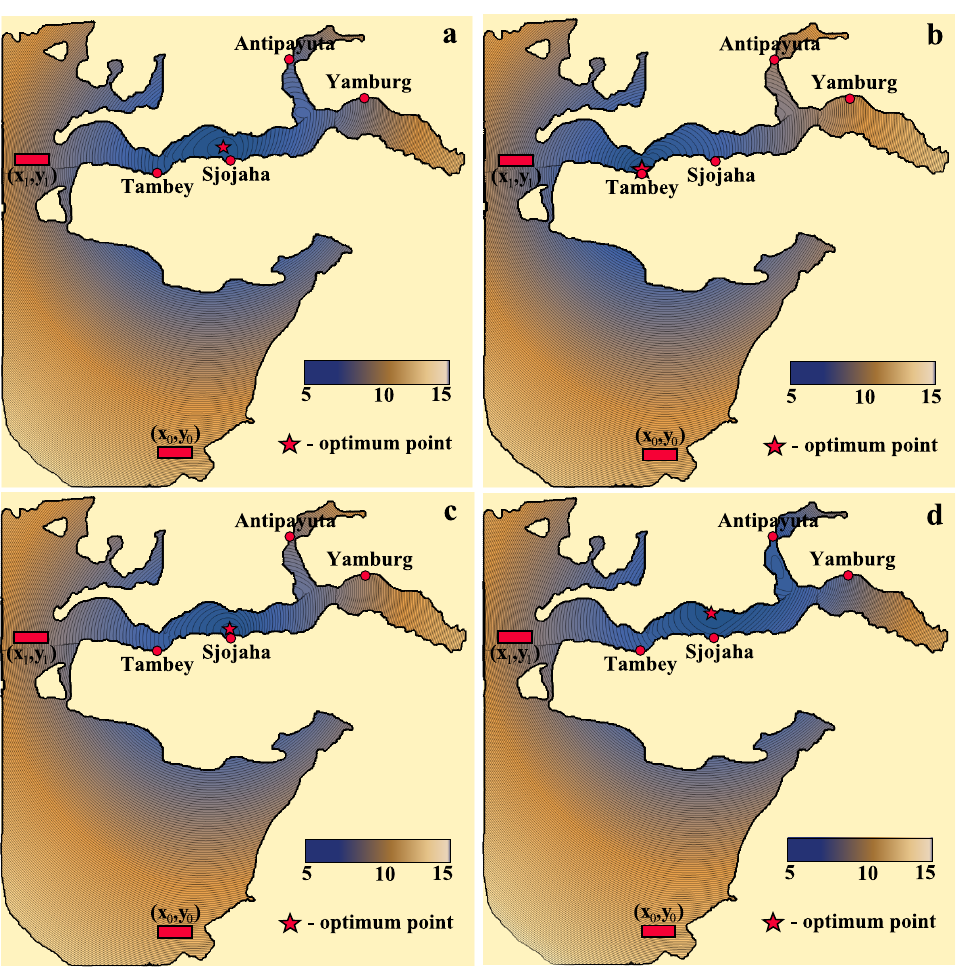
Figure 7. The economic benefit map for the values presented in Table 1: ( a ) case 1; ( b ) case 2; ( c ) case 3; ( d ) case 4. Calculation was carried out at m = 60 tons and F = 3300 USD/h. The optimum point for unloading is indicated by an asterisk. The color scale is set in the range from 5 × 10 5 USD to 15 × 10 5